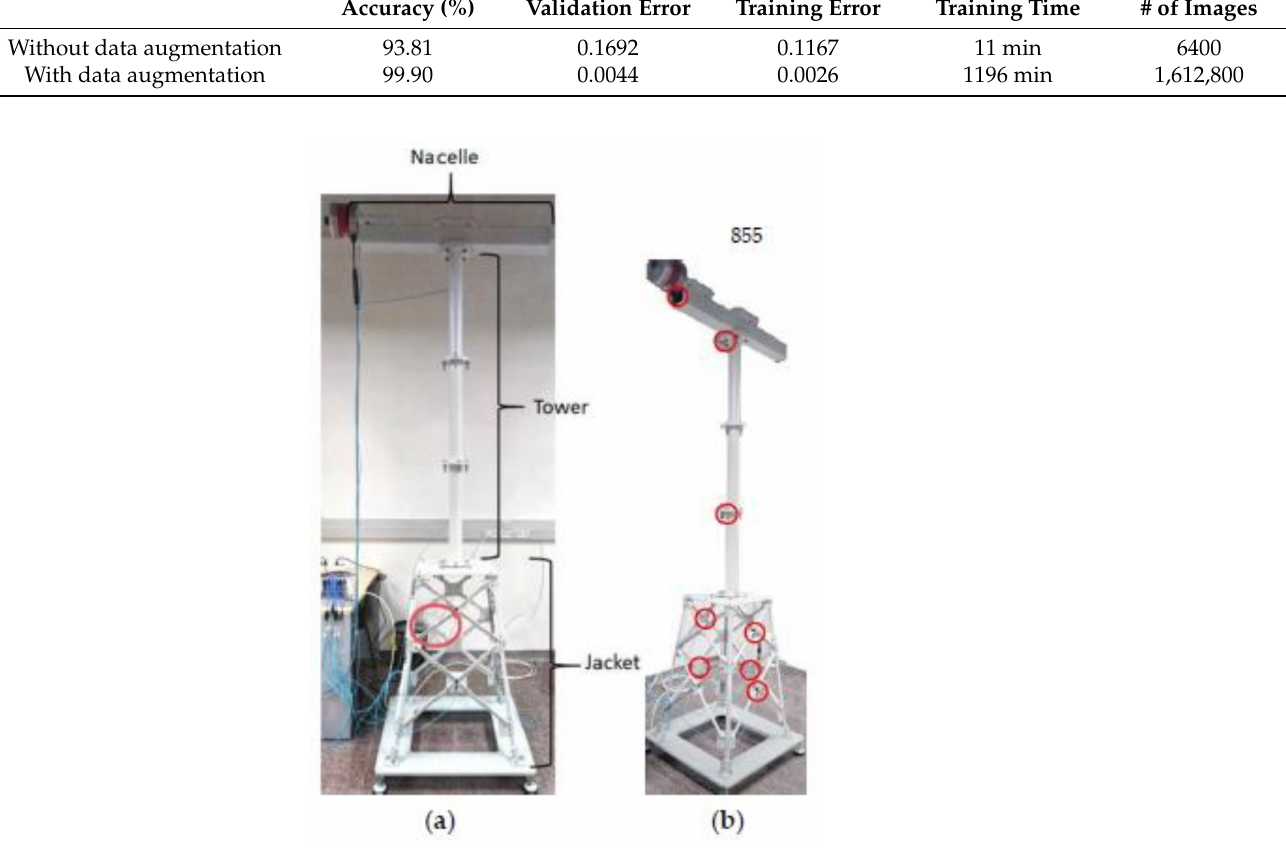
Figure 24. ( a ) An experimental setup with the damage location shown (red circle). ( b ) Locations of accelerometers